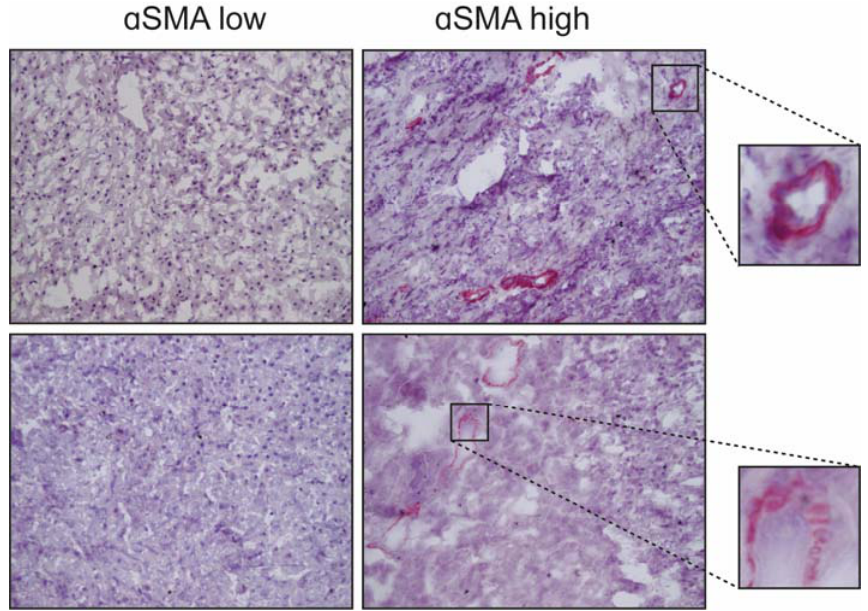
Figure 2. Staining of α‐ smooth muscle actin ( α SMA) in 4 HCC samples. The differentiated myofibroblasts within the tumour are the main cells expressing this actin isoform and are located in the stromal septa or around the blood vessels. Representative images at 10×. The small images are a 200× of the selected area.